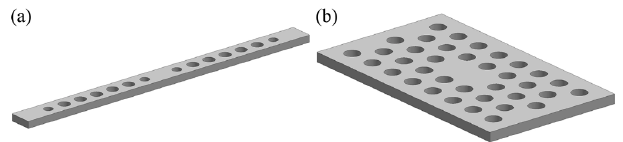
Figure 8. Schematics of ( a ) 1D PhC cavity and ( b ) 2D PhC cavity.